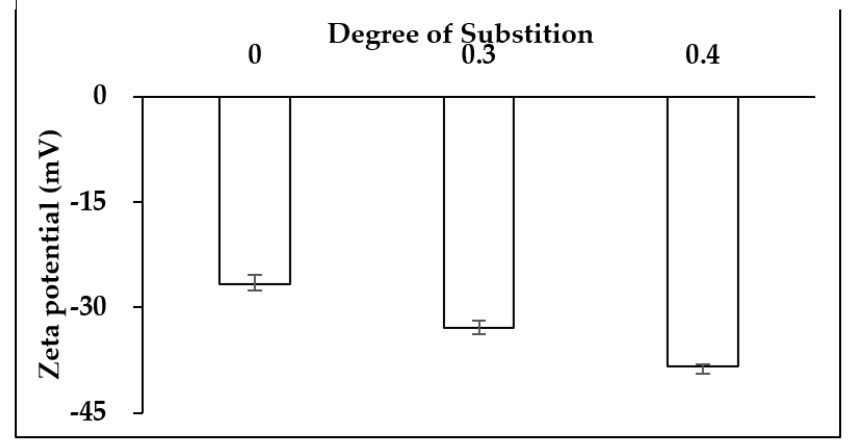
Figure 2. Zeta potential of different DS − treated green tea waste biomass.